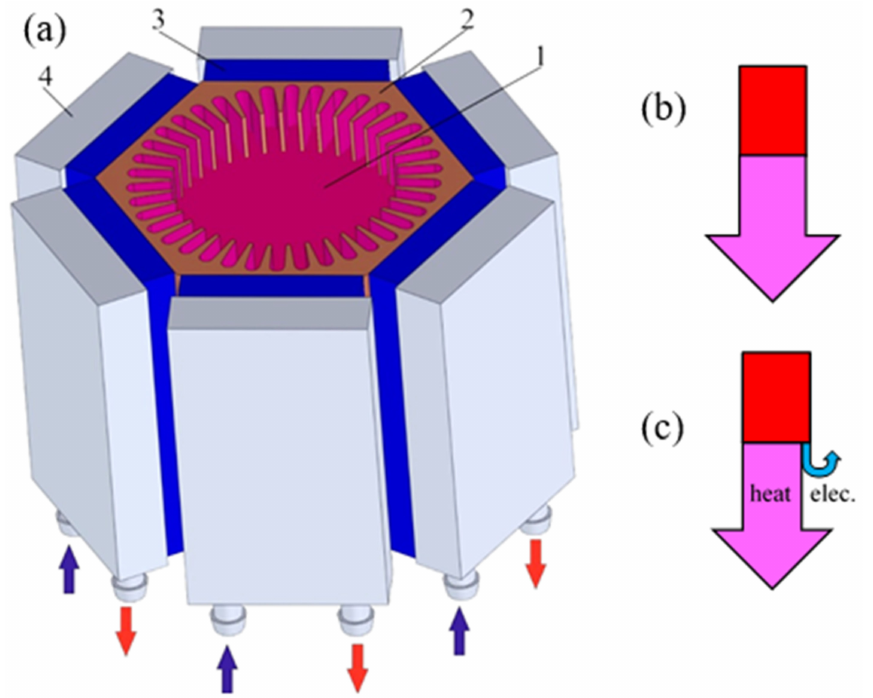
Figure 14. ( a )—Schematic view a gas thermoelectric generator (TEG); General view of a gas TEG; ( b , c )—Schematic energy flow diagram of a common gas burner and a hybrid TEG boiler; 1—fuel furnace; 2—heat exchanger; 3—TE module; 4—water